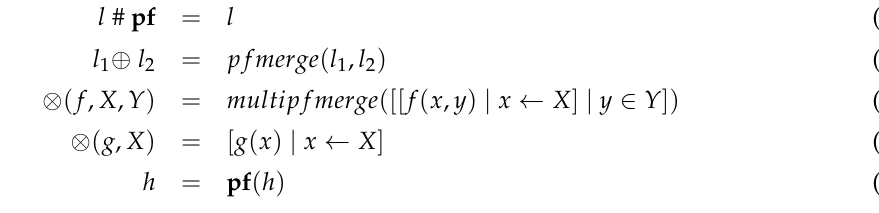
Algorithm 6 Merge B: The previous algorithm can be extended to move, from the right list, consecutive elements smaller than the first elements of the left